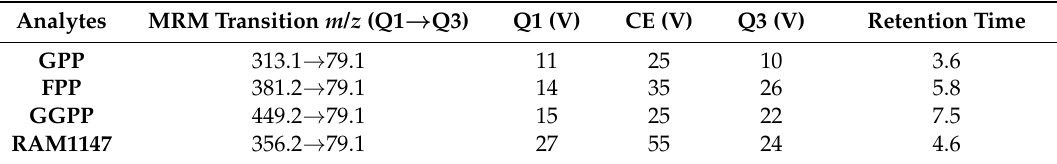
Table 1. Mass spectrometric parameters for individual isoprenoids (IsoPs): precursor to fragment ion transition, voltage potential (Q1), collision energy (CE) and voltage potential